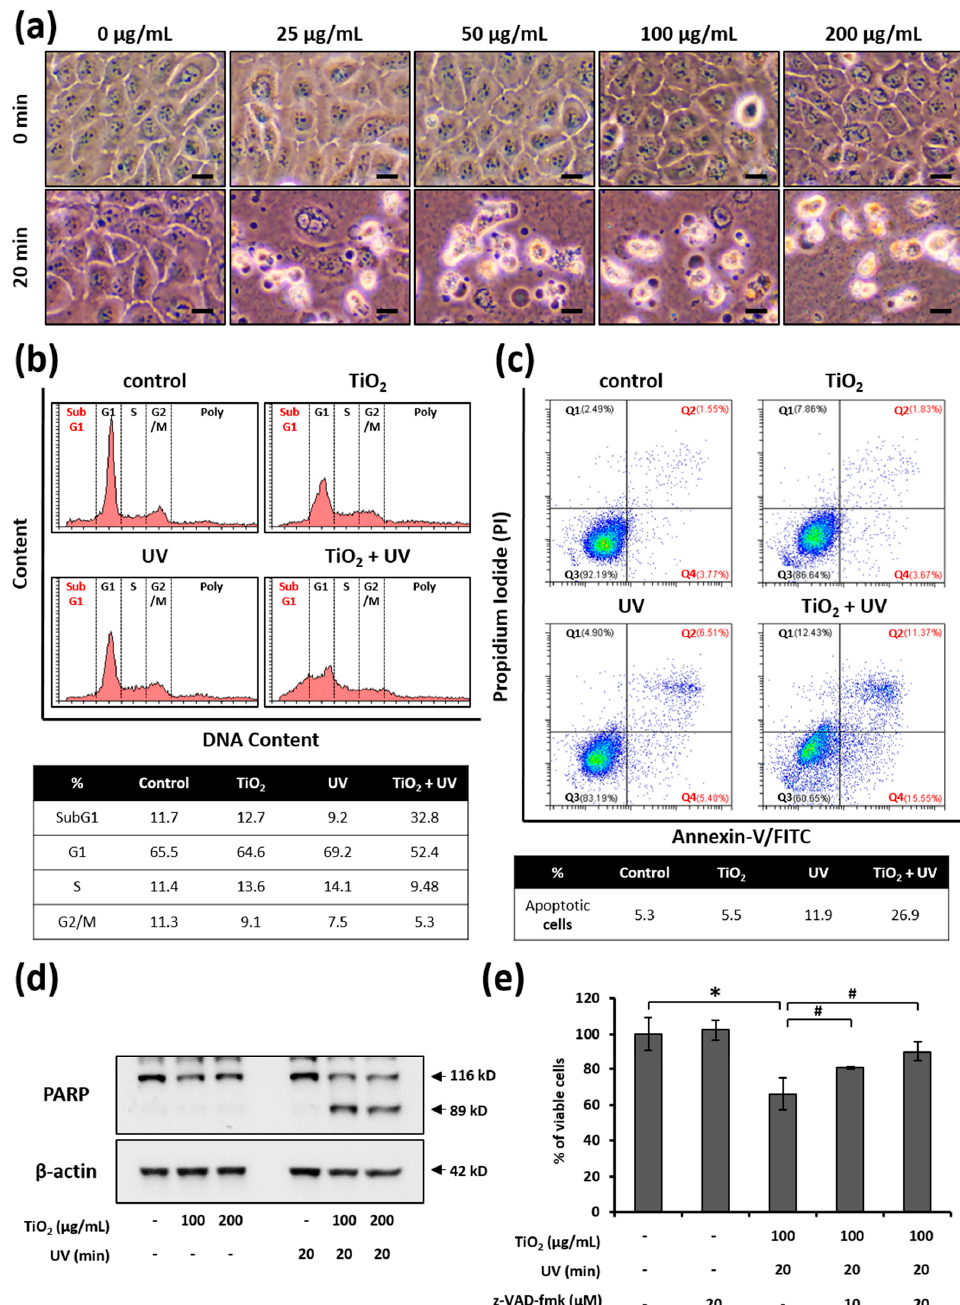
Figure 4. Apoptosis induction by the combination of TiO 2 NPs and UVA: ( a ) the treated cells were observed by bright-field microscopy. Scale bars correspond to 20 µ m; ( b ) HaCaT cells were treated with a combination of TiO 2 NPs and UVA. The DNA content was measured by flow cytometry after PI staining; ( c ) the treated cells were harvested and apoptosis was analyzed using the Annexin V-FITC Apoptosis Detection Kit by flow cytometry. The cells were classified as healthy cells